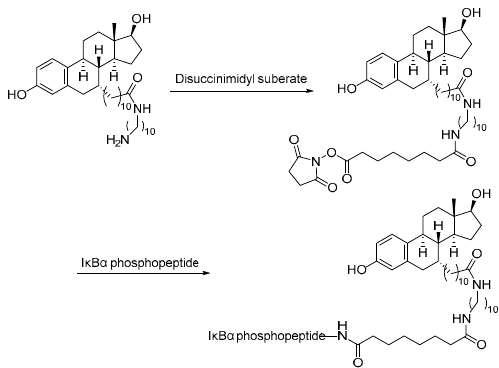
Scheme 2. Synthesis of C7-derivatized estradiol–based PROTAC.